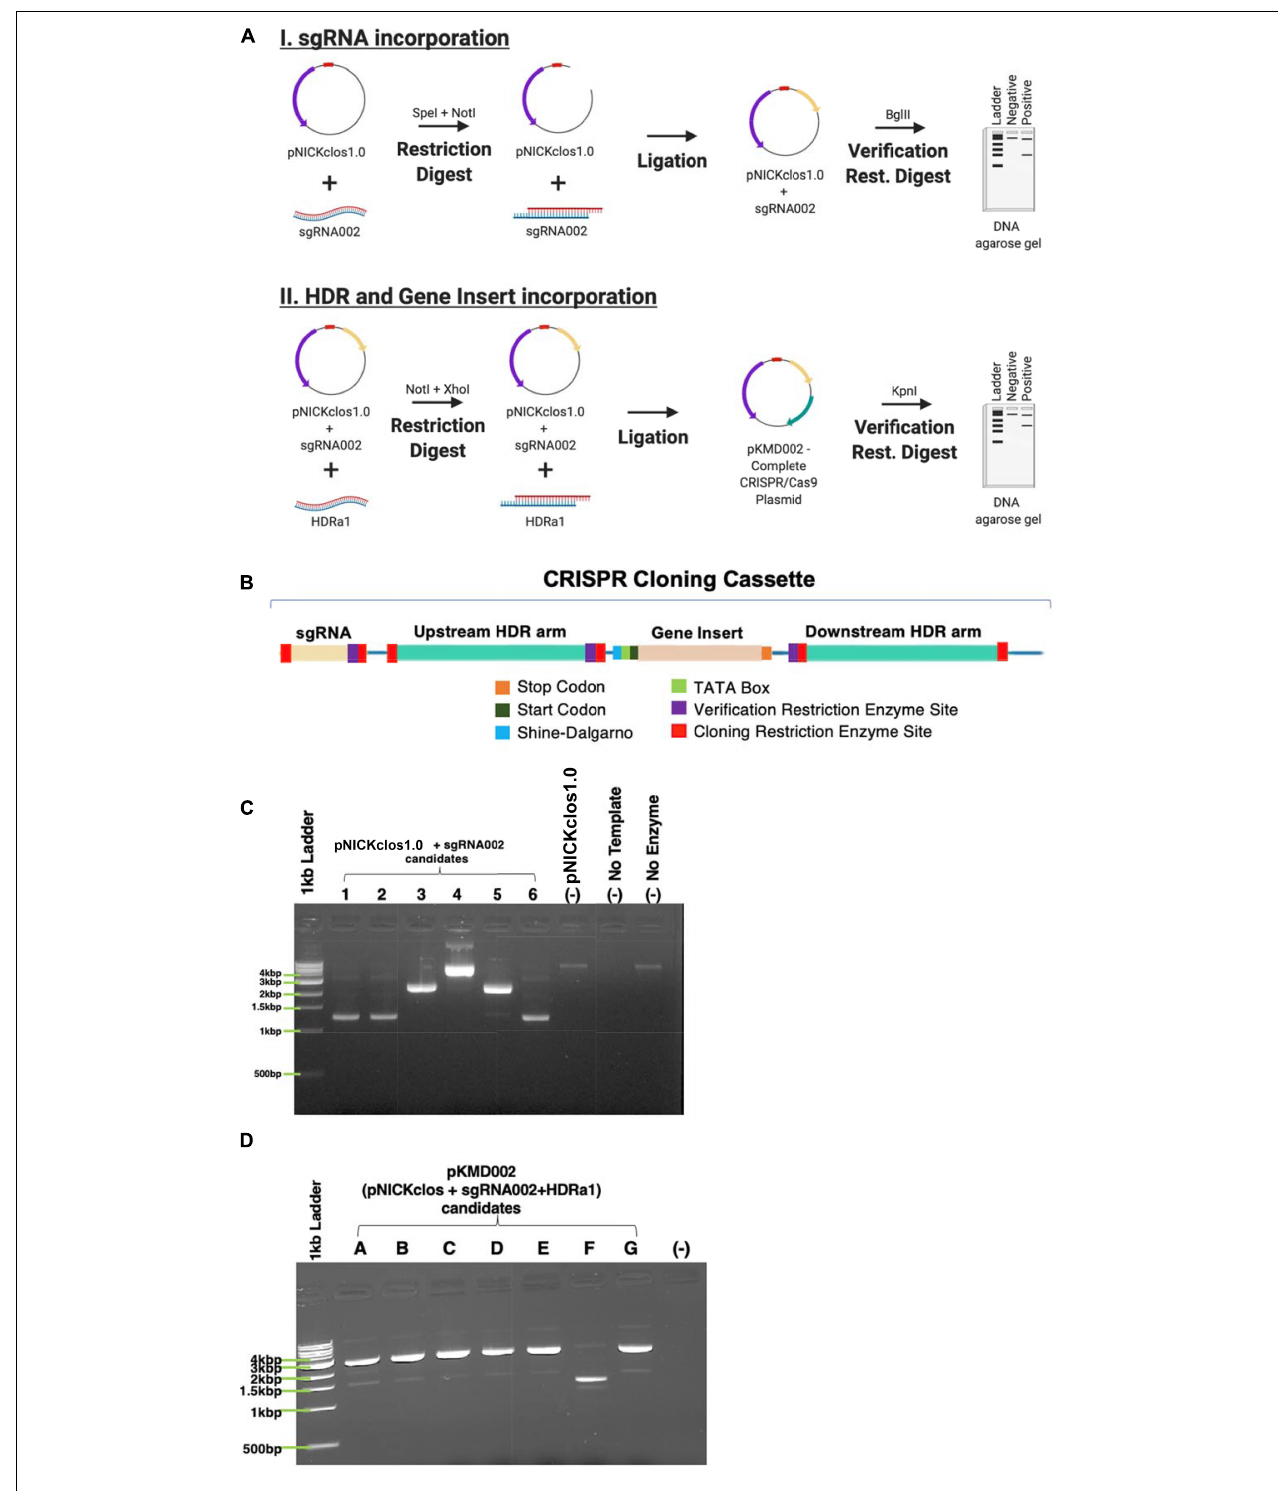
FIGURE 4 | Building the CRISPR/Cas9n plasmid. (A) Schematic representation of stepwise cloning method. (B) DNA domain map of CRISPR cloning cassette build and utilized within pNICKclos1.0 to generated plasmid (pKMD002) used in this study. (C) Verification restriction digests confirming the insert of sgRNA002 targeting NT01CX0401. Singlet is negative for insertion of desired sgRNA after digest with BglII, doublet indicates positive insertion. (D) Verification restriction digests confirming the insert of HDR cassette corresponding sgRNA002 to gene target NT01CX0401. Singlet is negative for insertion of desired sgRNA after digest with KpnI, doublet indicates positive